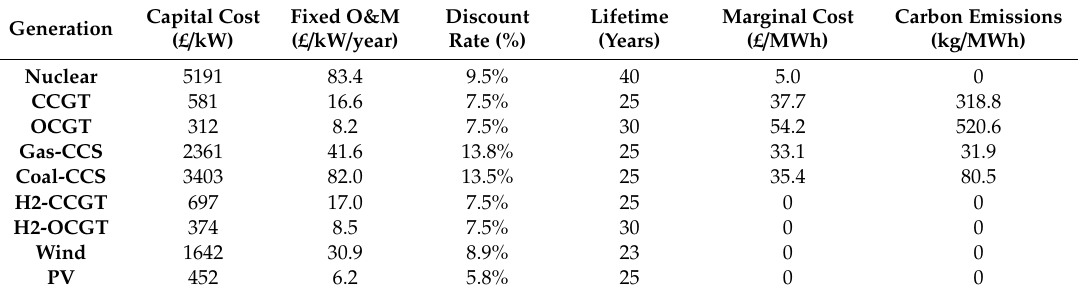
Table 1. Economic and operational parameters of the generation units.